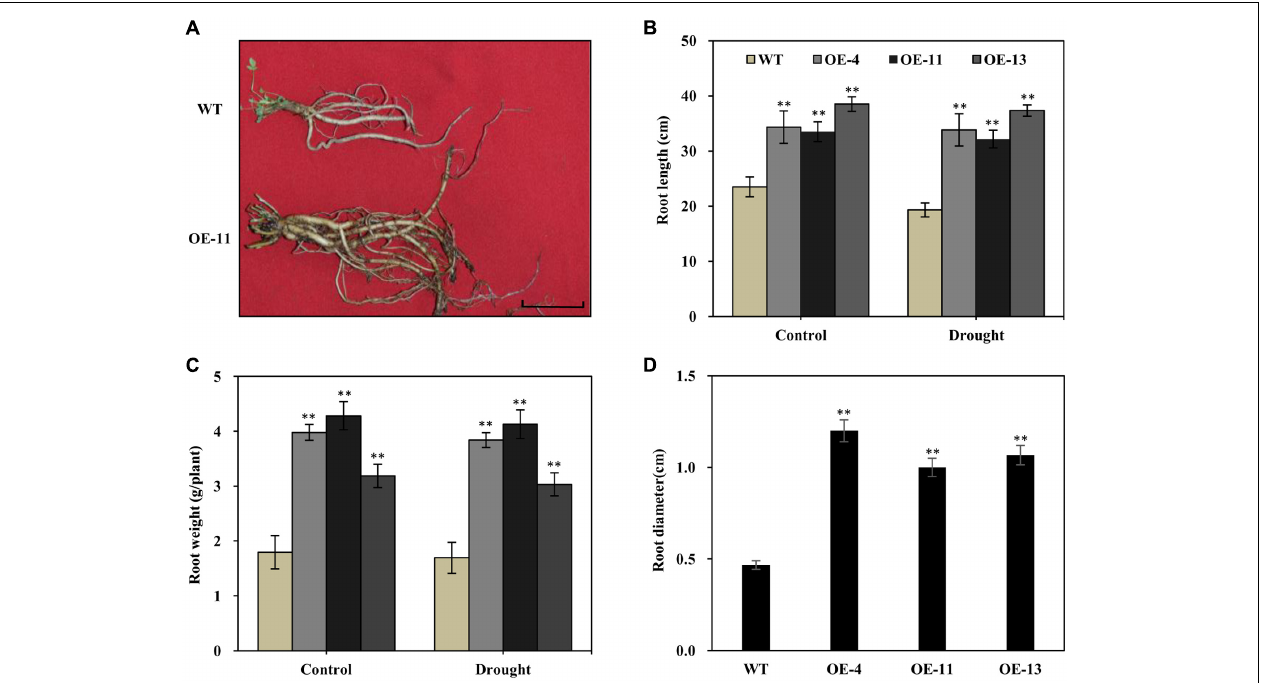
FIGURE 5 | Increased root length, weight, diameter, and chlorophyll content in the AtEDT1 transgenic alfalfa plants. (A) Root phenotype of wild type and transgenic alfalfa plants. Wild type and transgenic alfalfa plants with or without drought stress treatment were carefully dug out, and washed thoroughly with water. Bar = 5 cm. (B–D) Root length and fresh weight of wild type and transgenic alfalfa plants after drought stress treatment. Values are means ± SD of three replicates ( ∗ P < 0.05, ∗∗ P < 0.01). (D) Root diameter of wild type and transgenic alfalfa plants before drought stress treatment. Values are means ± SD of three replicates ( ∗ P < 0.05, ∗∗ P <